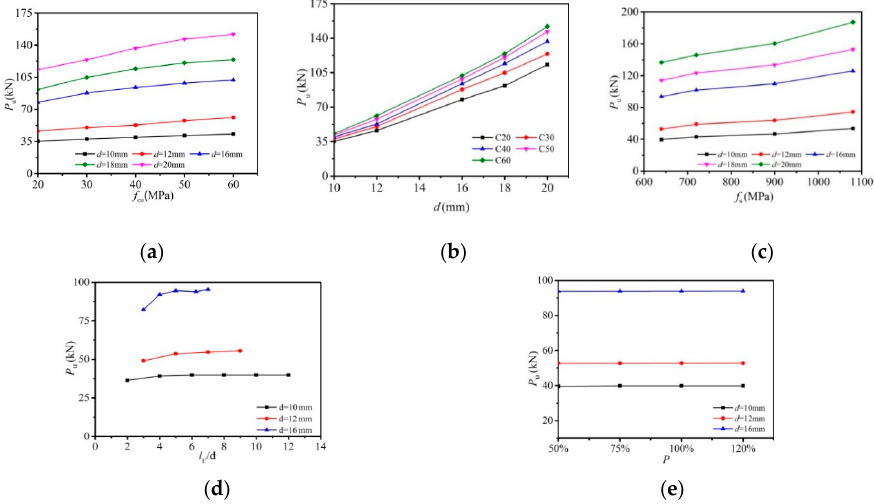
Figure 11. Main factors for shear capacity of high-strength bolt connectors: ( a ) e ff ect of concrete strength; ( b ) e ff ect of bolt diameter; ( c ) e ff ect of bolt yield strength; ( d ) e ff ect of length-to-diameter ratio; ( e ) e ff ect of bolt